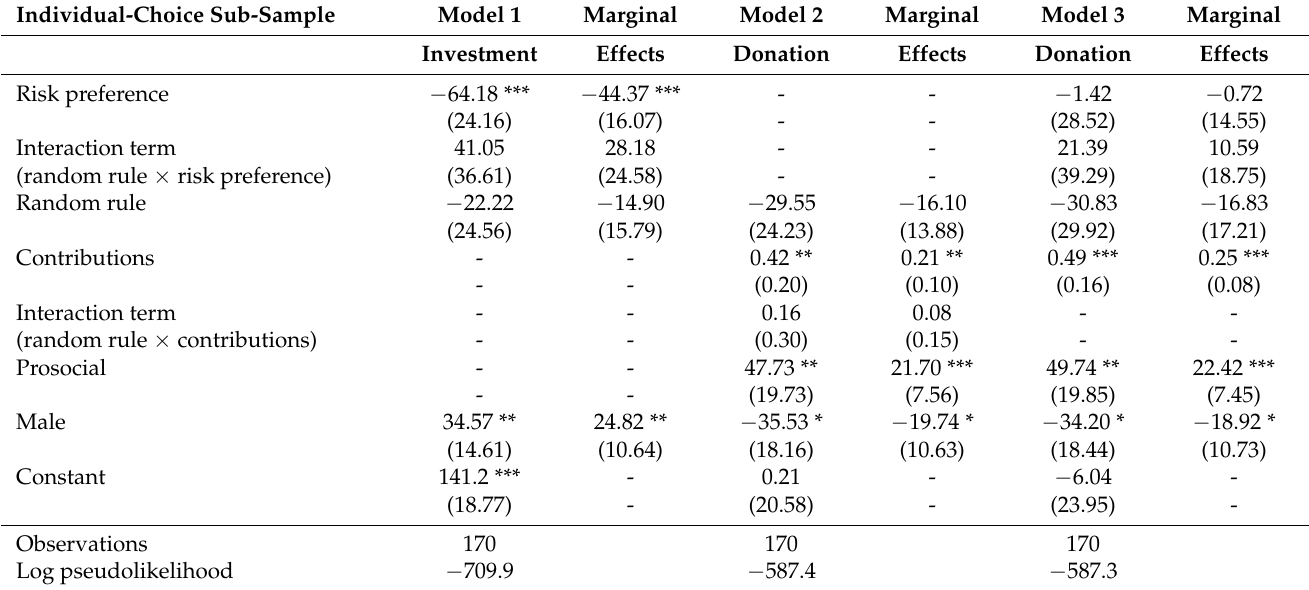
Table 8. Estimation results for the individual-choice sub-sample (Tobit